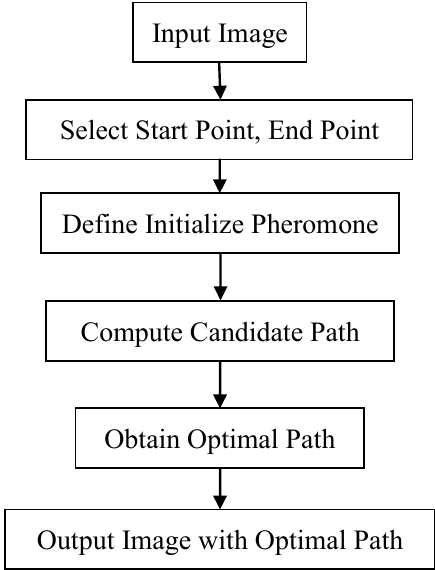
Figure 5. The flowchart of proposed ACO